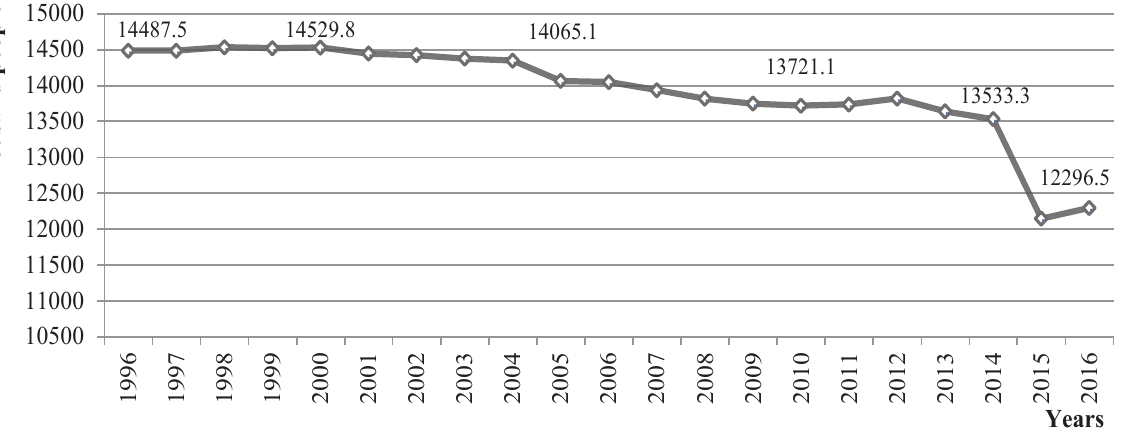
Figure 1. The dynamics in the number of pensioners in Ukraine in 1996–2016, thousand